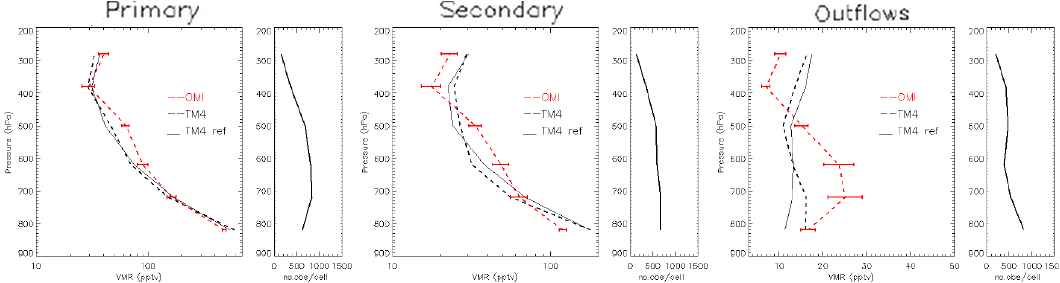
Figure 9. Cloud-slicing NO 2 VMR profiles for year 2006 by class: all primary sources (left), all secondary sources (middle) and all outflow classes (right). (OMI pseudoprofile, dashed red line; TM4 pseudoprofile, dashed black line; TM4 profile for cloudy conditions, continu- ous black line). The error bars show random retrieval errors. The differences between continuous and dashed black lines show systematic pseudoprofile